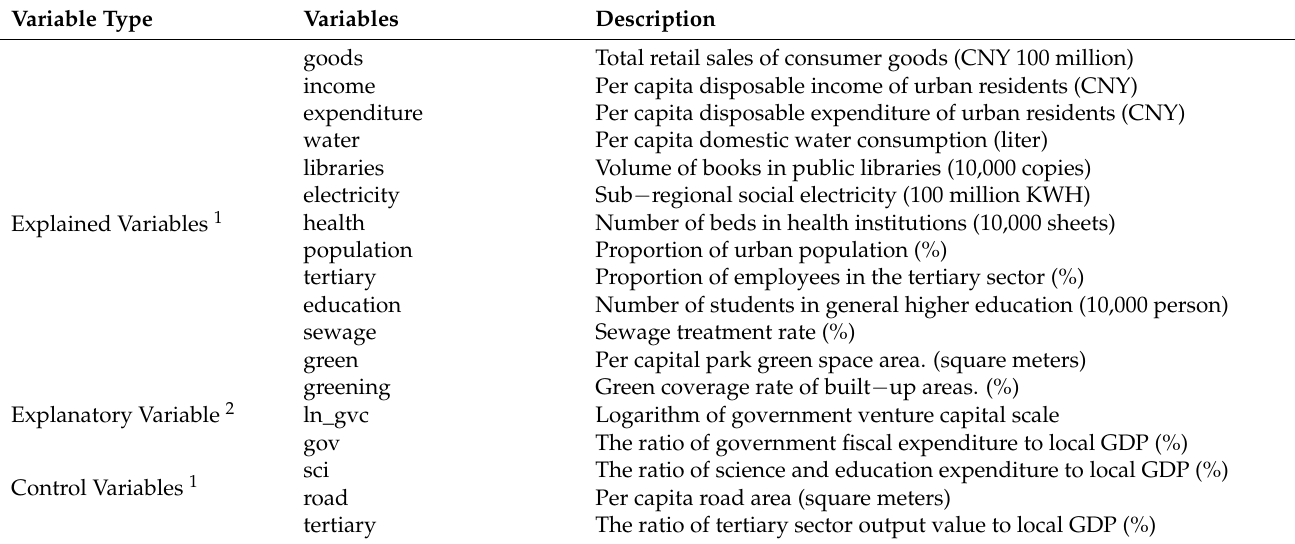
Table 2. Variable definitions.